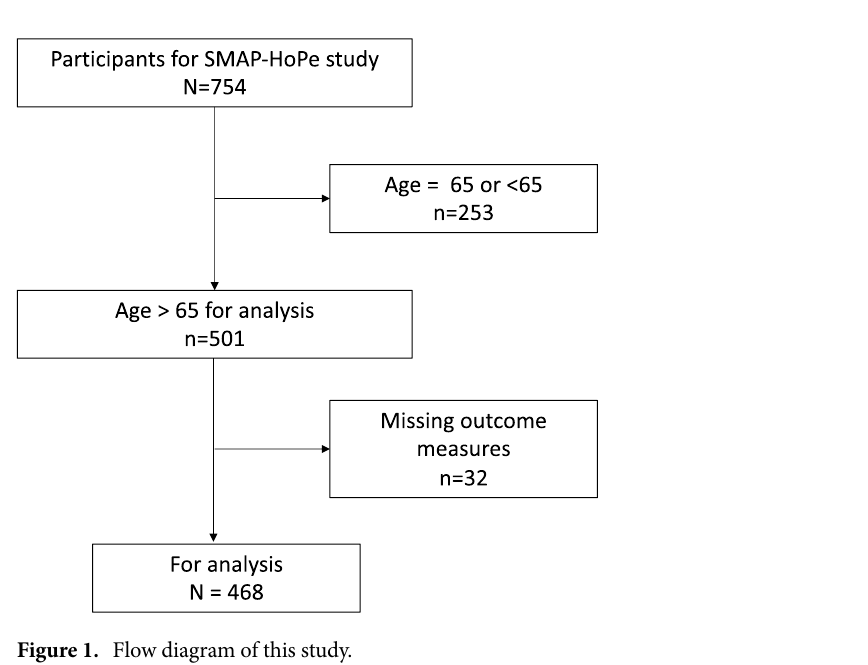
Figure 1. Flow diagram of this